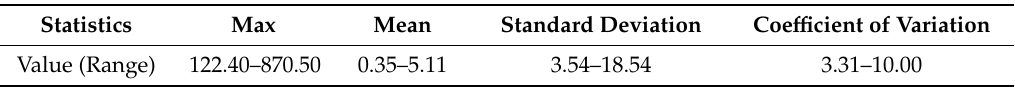
Figure 2. The 55 rainfall gauge stations in the study area (Latitude: 34.3959–38.2509 ◦ N, Longitude: 126.3812–129.4128 ◦ E). Table 1. Basic statistics of daily rainfall series of 55 rainfall gaging stations: all basic statistics of each station are in Supplementary Materials, Appendix A.